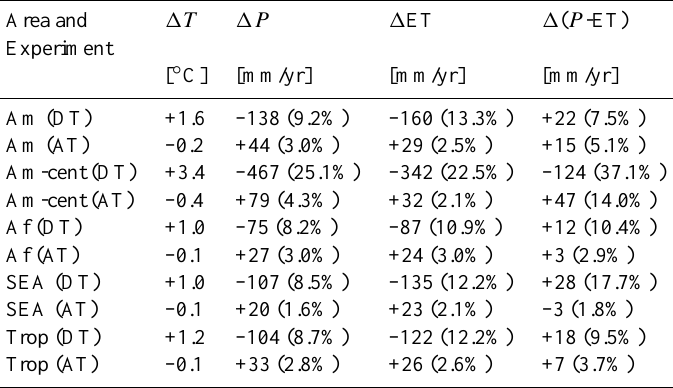
Table 4. Changes in surface temperature ( T ), precipitation ( P ), evapotranspiration (ET) and moisture convergence ( P -ET) in the Amazon (Am), central Amazon (Am-cent), tropical Africa (Af), South-Eastern Asia (SEA) and the whole tropics (Trop) in the years 11–300. Am-cent consists of 8 grid cells with the boundaries 73 ◦ W, 58 ◦ W, 7.5 ◦ S and the equator.